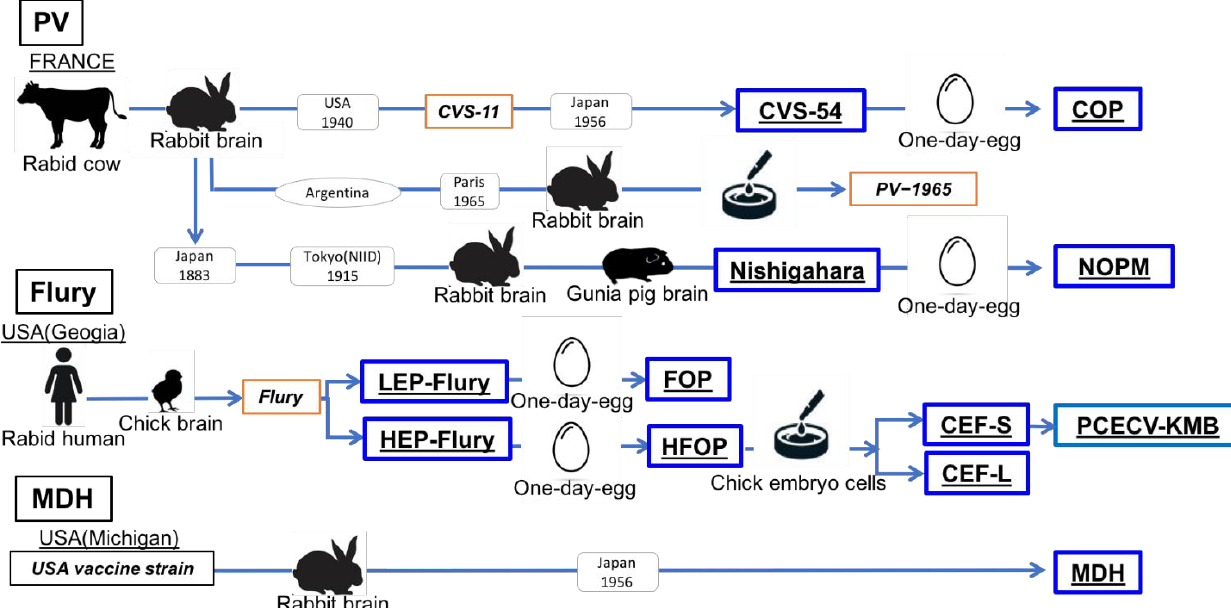
Figure 4. Schematic representation of the lineage of fixed strains used as vaccine seeds and analyzed in this study, as well as the other relevant strains. The strains sequenced in this study are highlighted. Strains not analyzed in this study are listed in italics.